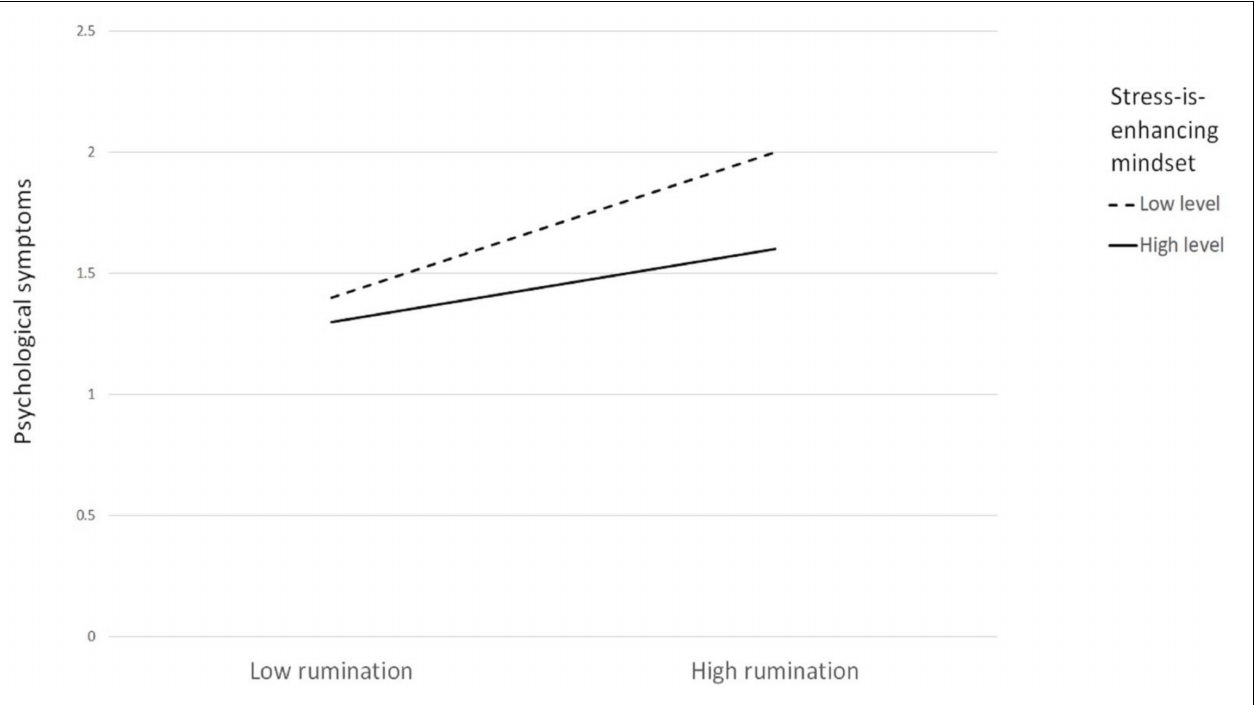
FIGURE 2 | The interaction between rumination and stress-is-enhancing mindset on psychological